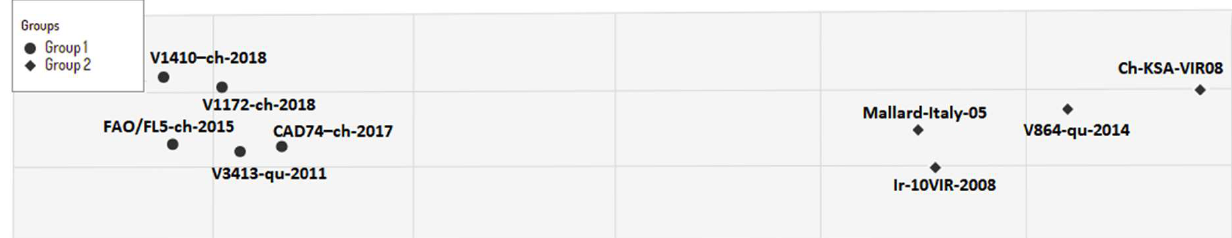
Figure 4. Antigenic cartography based on the hemagglutination inhibition (HI) titers of the sera of the Egyptian H9N2 virus strains used in this study and representative virus isolates of different antigenic clusters. Each point indicates a virus and both axes represent antigenic distance. The spacing between grid lines represents 1 antigenic unit distance, corresponding to a 2-fold dilution in the HI assay.